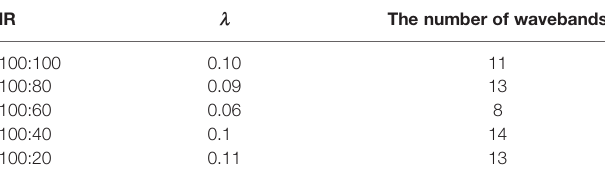
TABLE 1 | Determined parameters for different